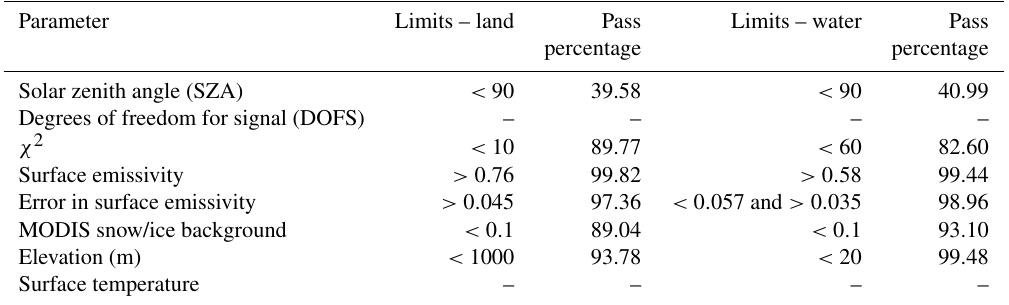
Table 1. Parameters used for filtering and evaluating the MOPITT data to minimize outliers in the dataset, and the percentage of retrievals that pass the specified